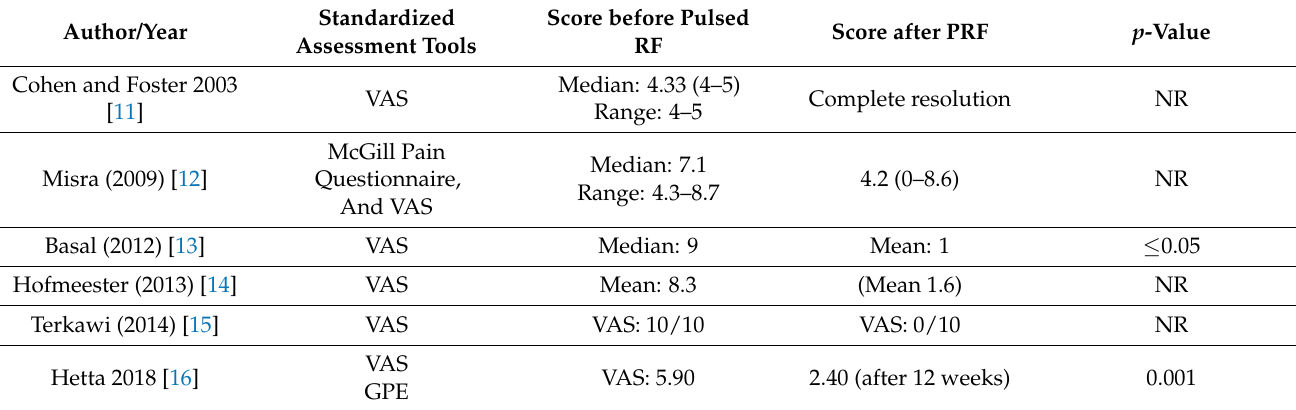
Table 5. Pain scale assessment before and after pulsed radio-frequency therapy for